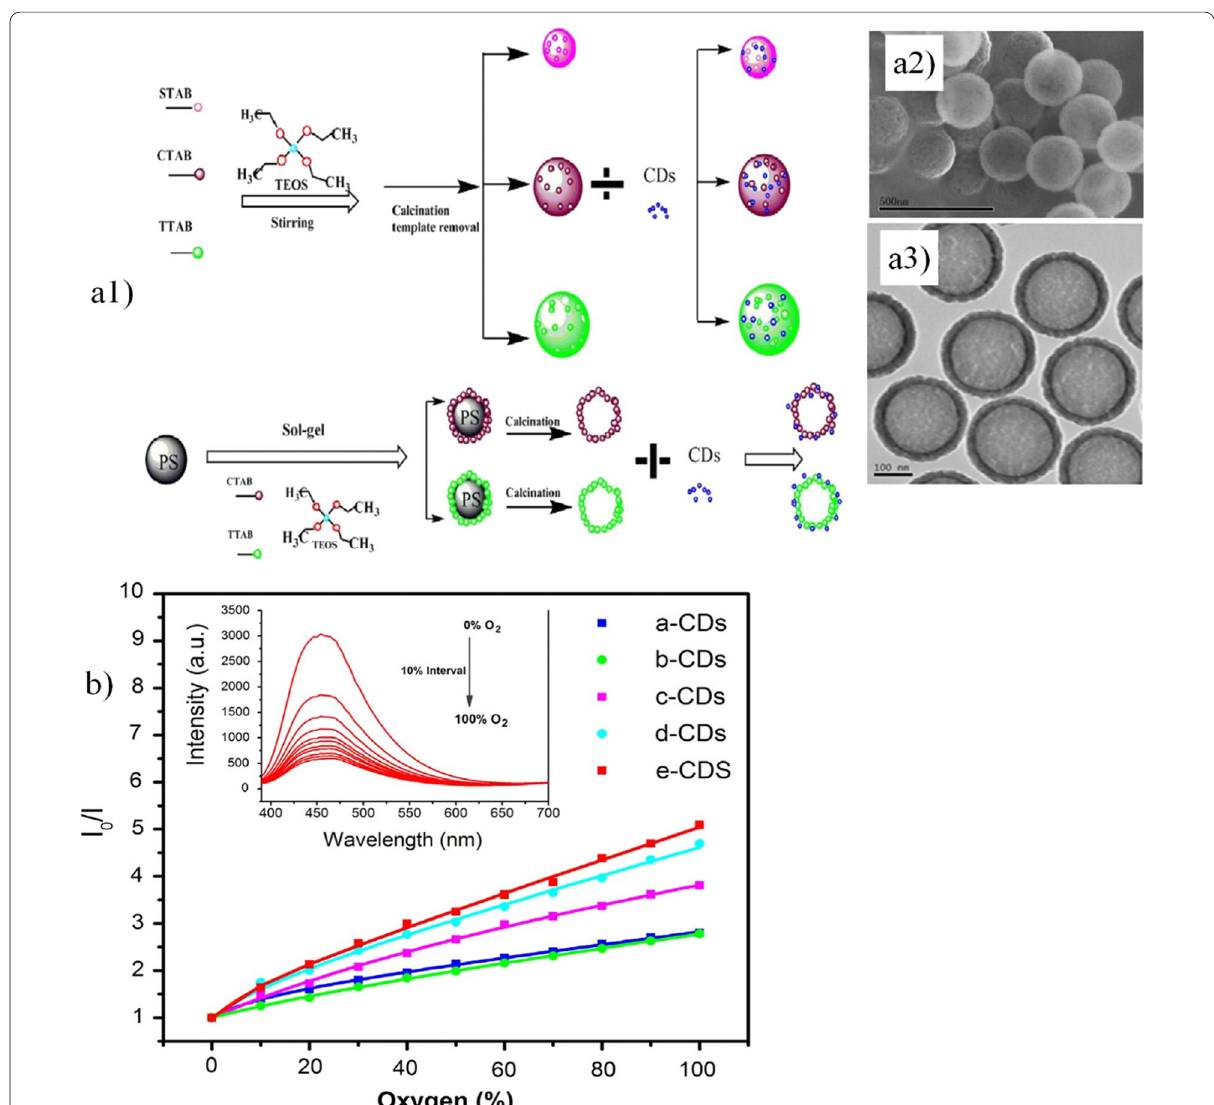
Fig. 2 a1 Scheme of the construction of the nanosensor for oxygen sensing, a2 , a3 FE‑SEM and TEM micrographs showing the morphology of the nanoparticles, b graph presenting the variation in fluorescence intensity as a function of the concentration of oxygen, and Stern–Volmer plot showing the quenching degree of the luminophore. Adapted with permission from ref. [190] Copyright 2016